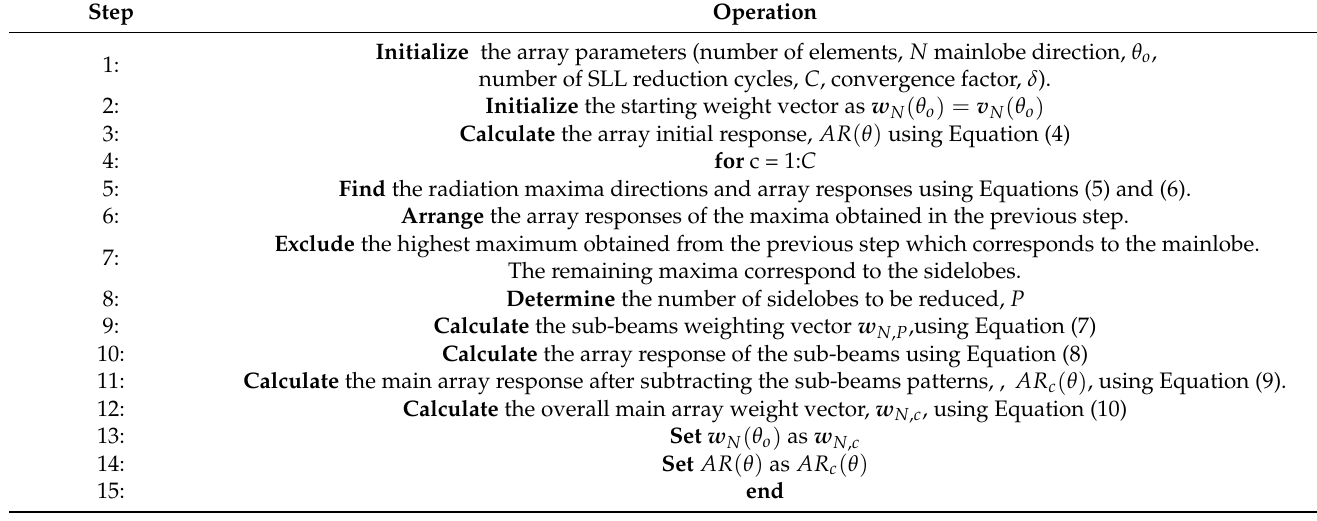
Table 1. SSR Algorithm for Simultaneous SLL